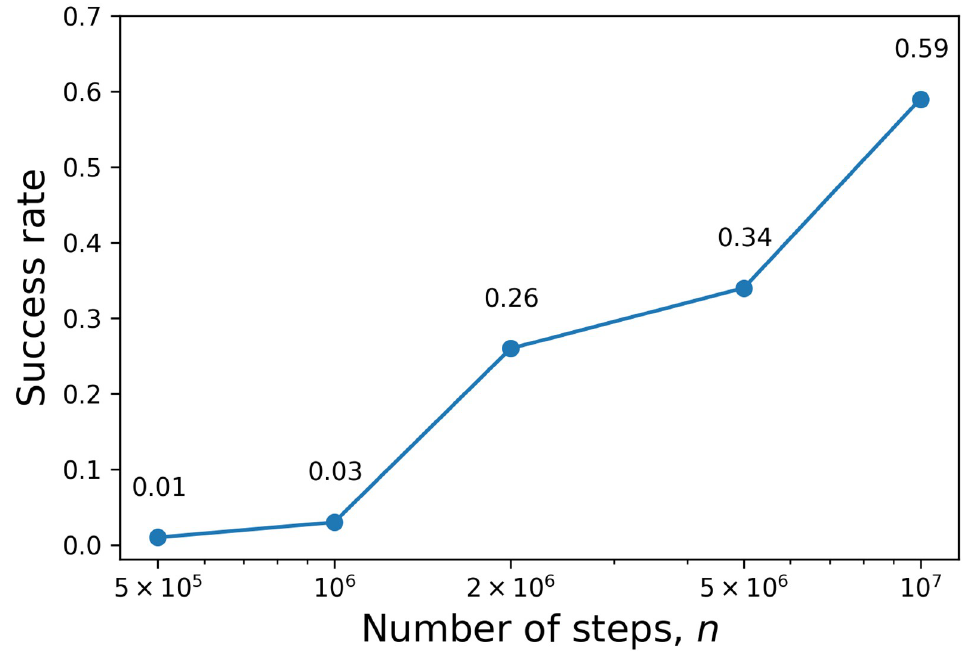
Fig 4. Success rate out of 100 trials in the SSA